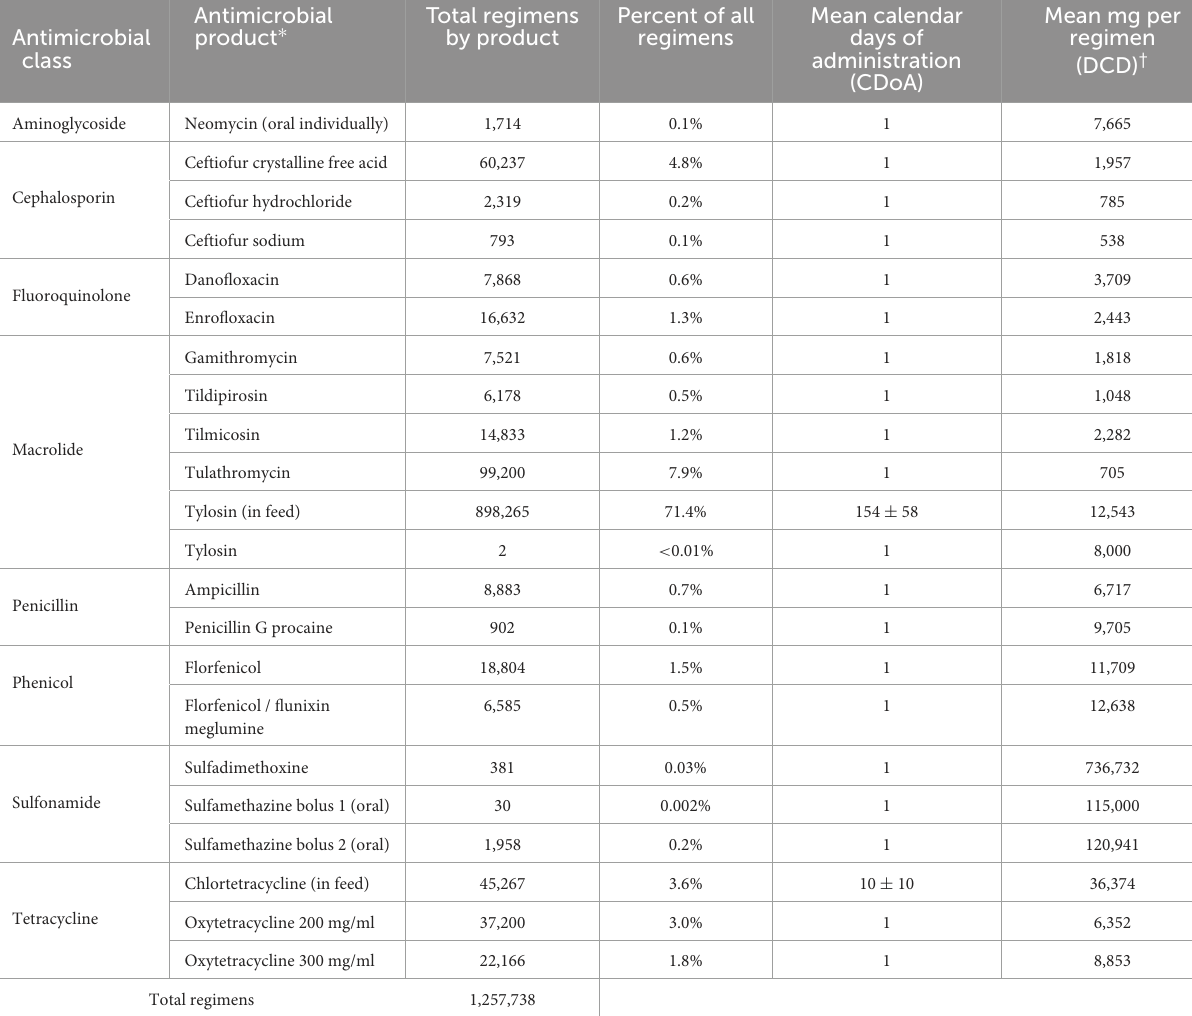
TABLE 1 Calculated DCD values used in the analysis.